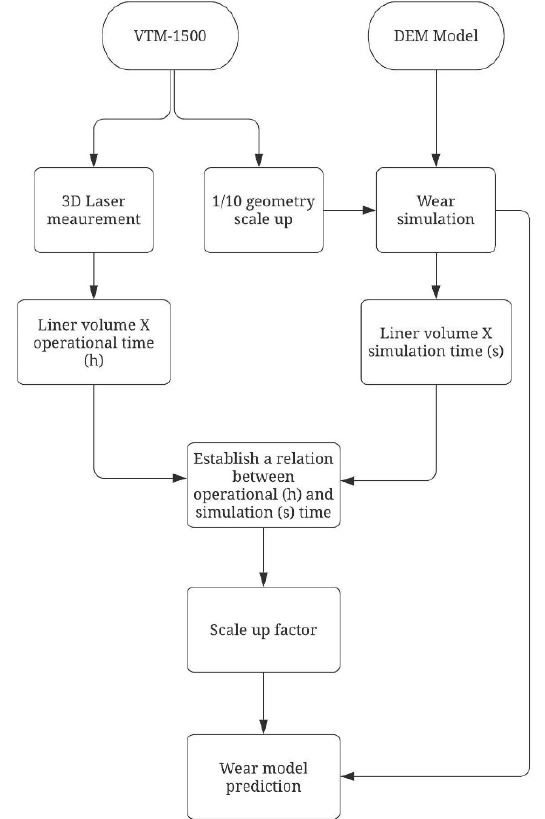
Figure 10. A flowchart explaining the wear model development based on the DEM model and VTM-1500 equipment.